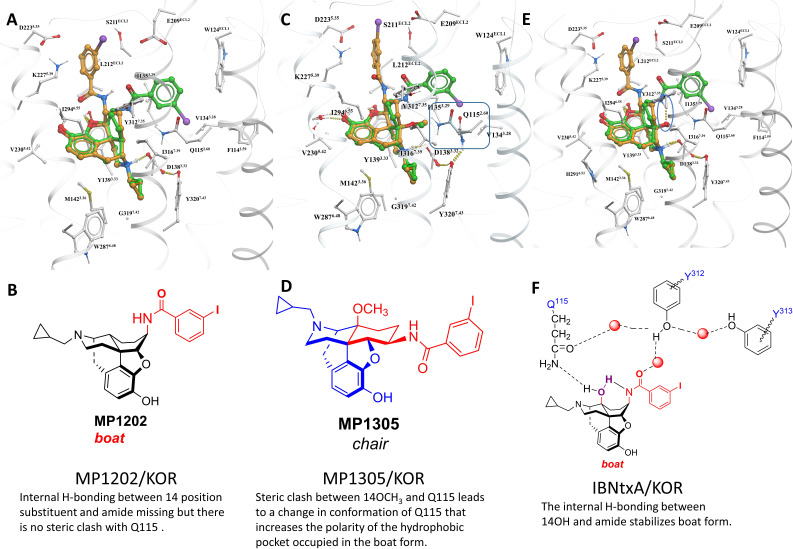
MP1305 is G protein biased at KOR.Docking pose for ligands inside active state KOR shown in white carbon sticks and white ribbon representations. (A–B) MP1202 in KOR favors boat conformation. (C–D) MP1305 in KOR favors chair conformation. 14th-position-Methoxy of MP1305 causes sidechain of Q1152.60 residue to undergo a conformational change, when compared to ligands with non-Methoxy substitutions at 14th-position (shown in cyan colored carbon sticks representation). (E) IBNtxA in KOR favors boat conformation. (F) Stabilization of IBNtxA in boat form through internal hydrogen-bonding between 14-OH and amide and with Q1152.60 is shown. The docked and energy minimized pose of MP1305 shows the substitution of 14-OH with larger methoxy group displaces the conserved Q1152.60 of KOR. In ligands with 14-OH, the Q1152.60 residue of KOR is directed toward the ligand and forms hydrogen bonds with the 14-OH. In the case of MP1305, the methoxy group pushes Q1152.60 residue away to avoid steric clashes, and the polar terminus of the side chain ends up in the previously hydrophobic TM2-TM3 sub-pocket of KOR. Furthermore, due to internal ligand sterics, the internal hydrogen bond between the amide and 14-OH, as seen in compounds such as IBNtxA, is not possible for MP1305. The combination of these two factors, increasing polarity of the hydrophobic TM2-TM3 sub-pocket (an effect similar to Y312W6.35 KOR sub-pocket mutation- and lack of an internal hydrogen bond stabilizing the boat form, shifts the equilibrium toward the chair form for MP1305).